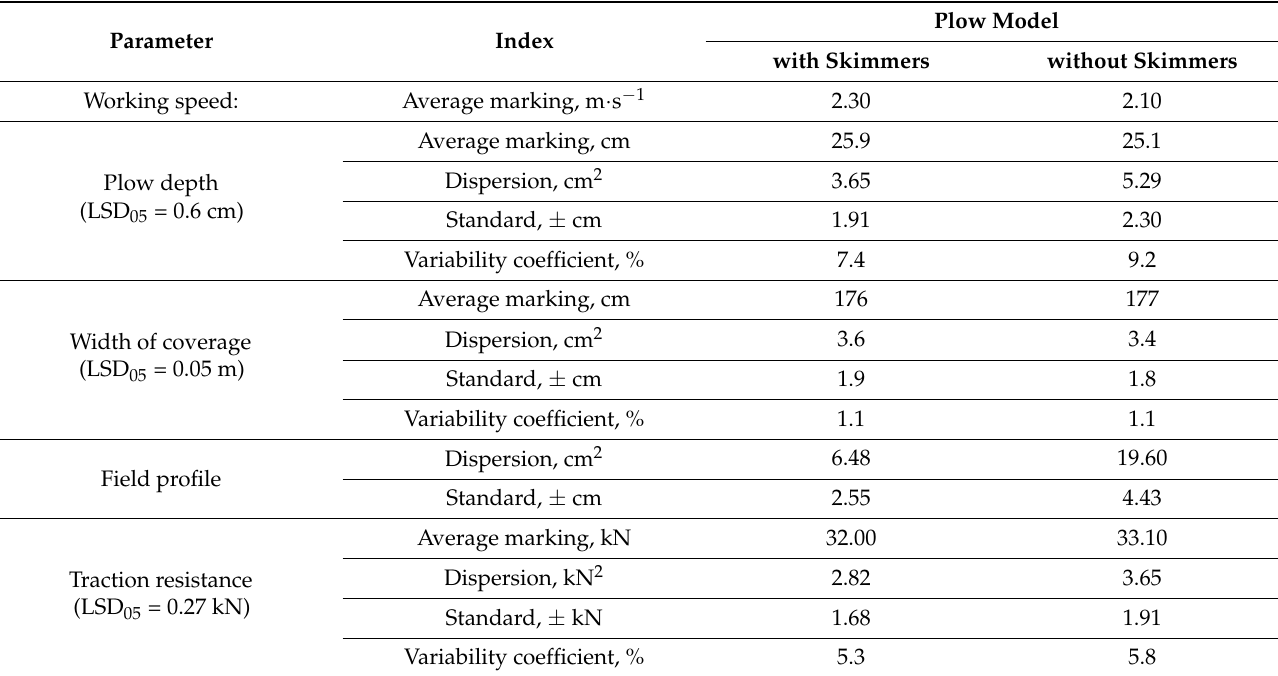
Table 4. Efficiency indices of the PLN-5-35 plow with skimmers and